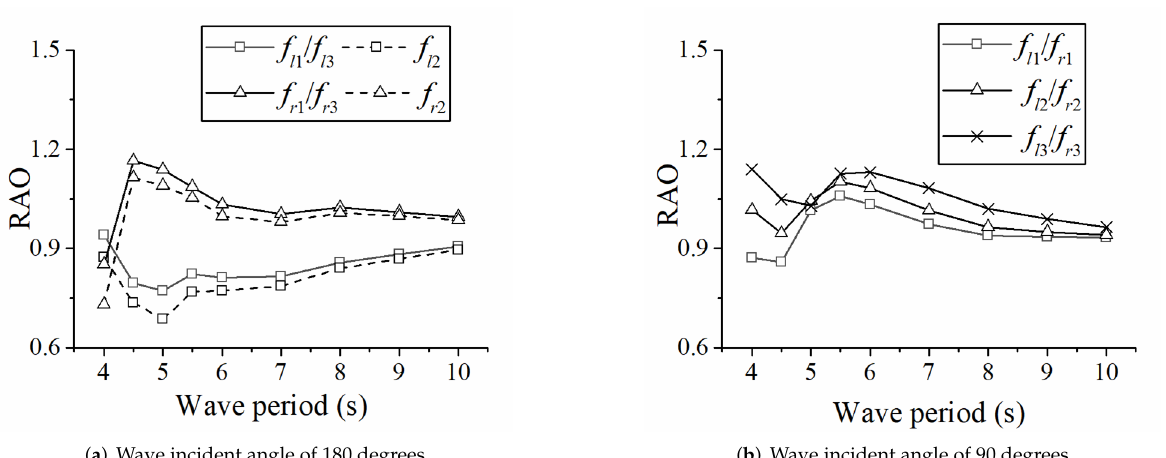
Figure 9. Heave motion response of floaters in different wave periods (three floaters on one